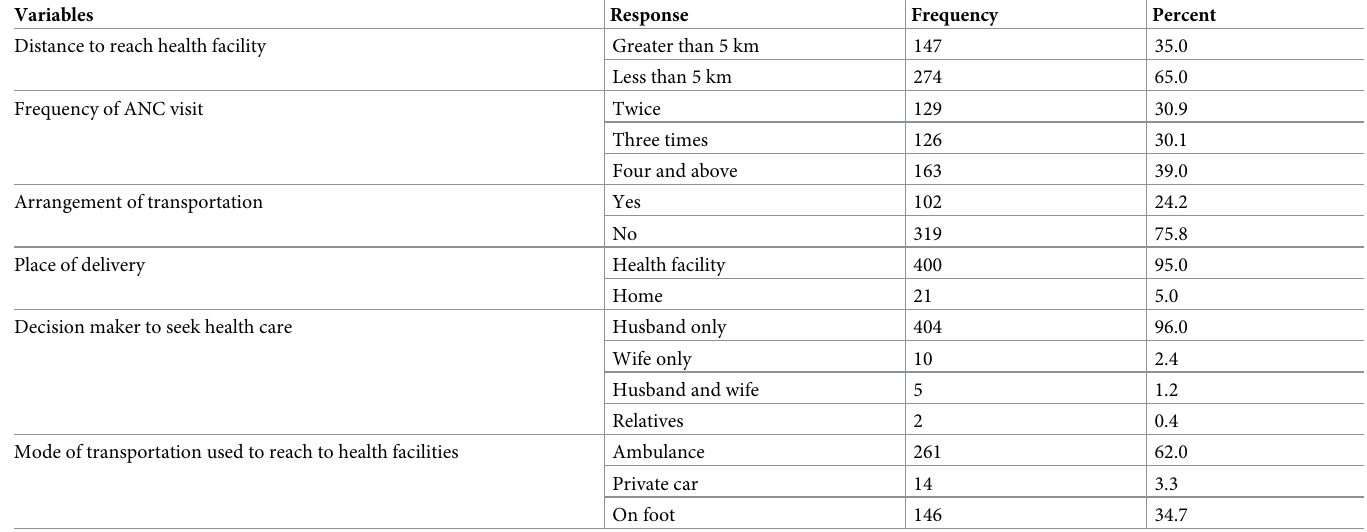
Table 2. Reproductive health and transportation related information of respondents in Kucha district, Gamo zone, Southern Ethiopia, 2018. Variables